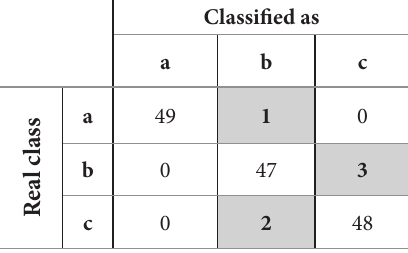
Table 2. Confusion matrix for default classes Classified